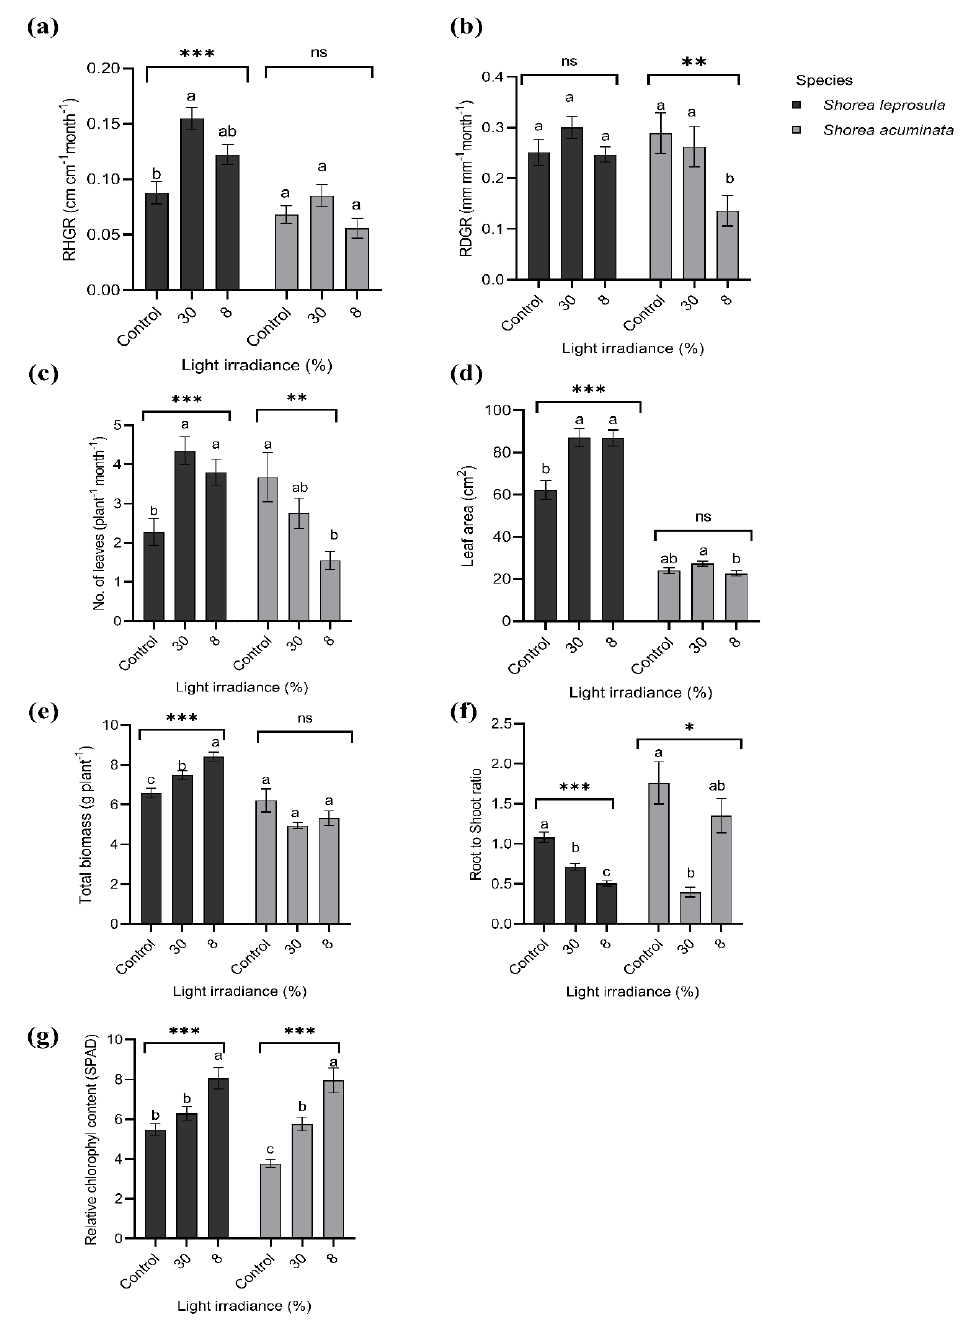
Figure 4. The growth performance of Shorea leprosula Miq. and Shorea acuminata Dyer to different light irradiances; ( a ) relative height growth rate (RHGR) (cm cm − 1 month − 1 ); ( b ) relative diameter growth rate (RDGR) (mm mm − 1 month − 1 ); ( c ) mean number of leaves (plant − 1 month − 1 ); ( d ) leaf area (cm 2 ); ( e ) biomass (g plant − 1 ); ( f ) root-to-shoot ratio; and ( g ) relative chlorophyll concentration (SPAD) (mean ± SE). Alphabets denote significant differences between light irradiance treatments with *, **, and *** indicating significant at p < 0.05, p < 0.01, and p < 0.001, respectively; ns =